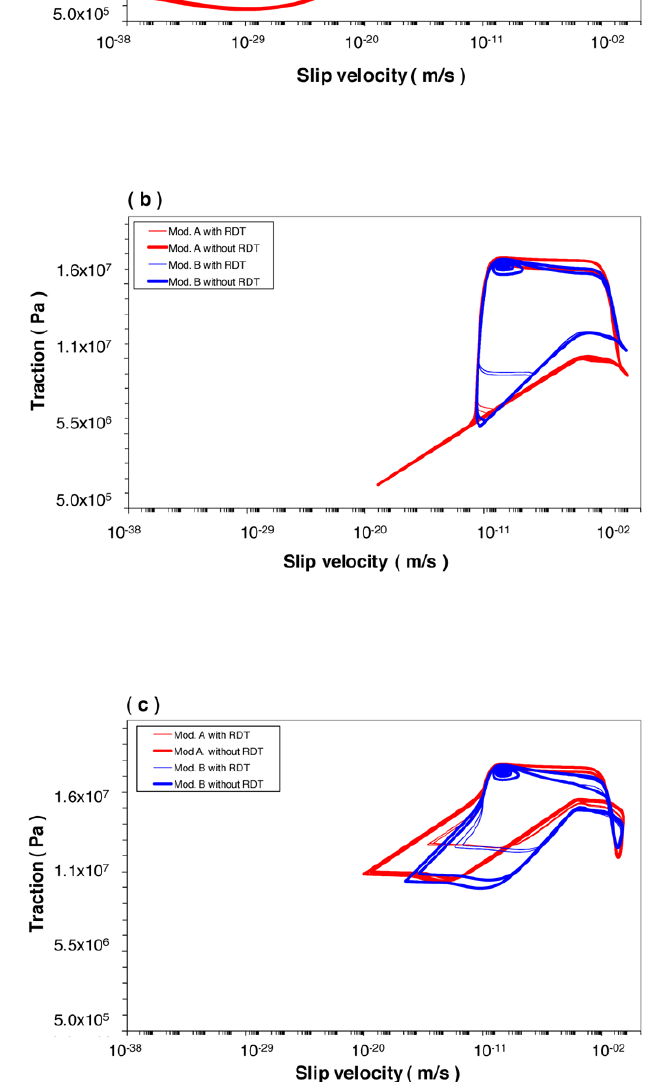
Figure A1. Phase diagrams without normalization for the reference config- urations and for the three different governing models considered in this study. Panels (a), (b) and (c) correspond to Figures 1d, 2d and 3d,